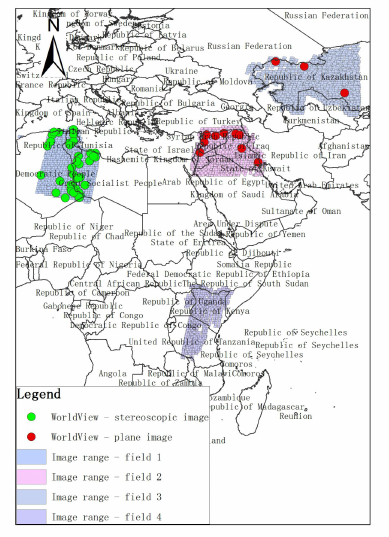
Figure 2. Distribution of WorldView